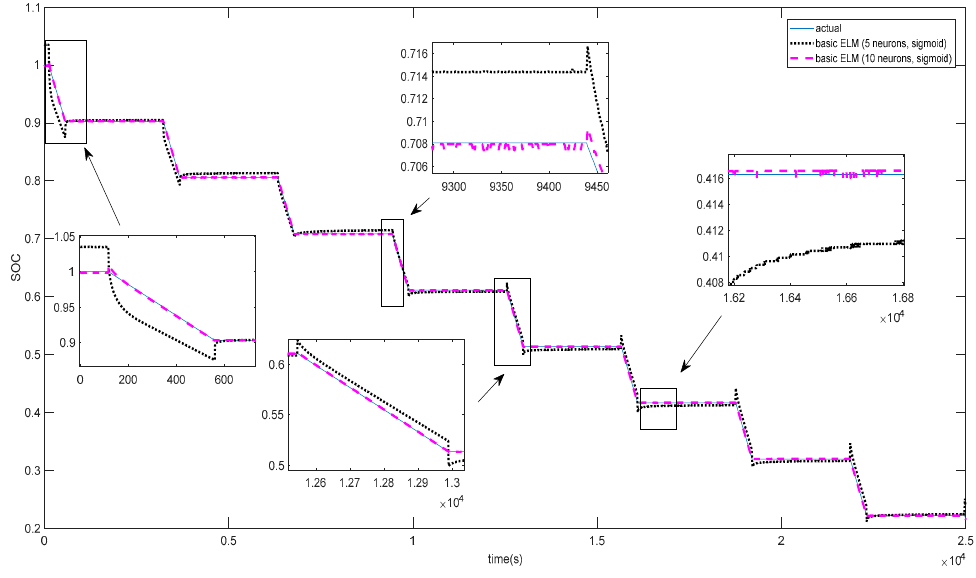
Figure 12. Different number of neurons used in basic ELM.